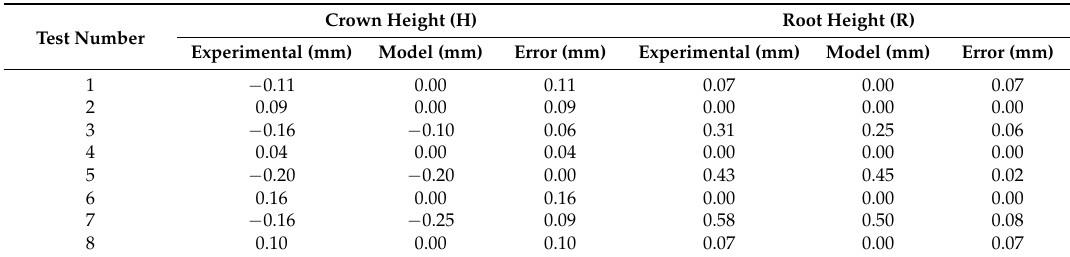
Table 7. Geometrical validation of the model (fillet-groove and sag).